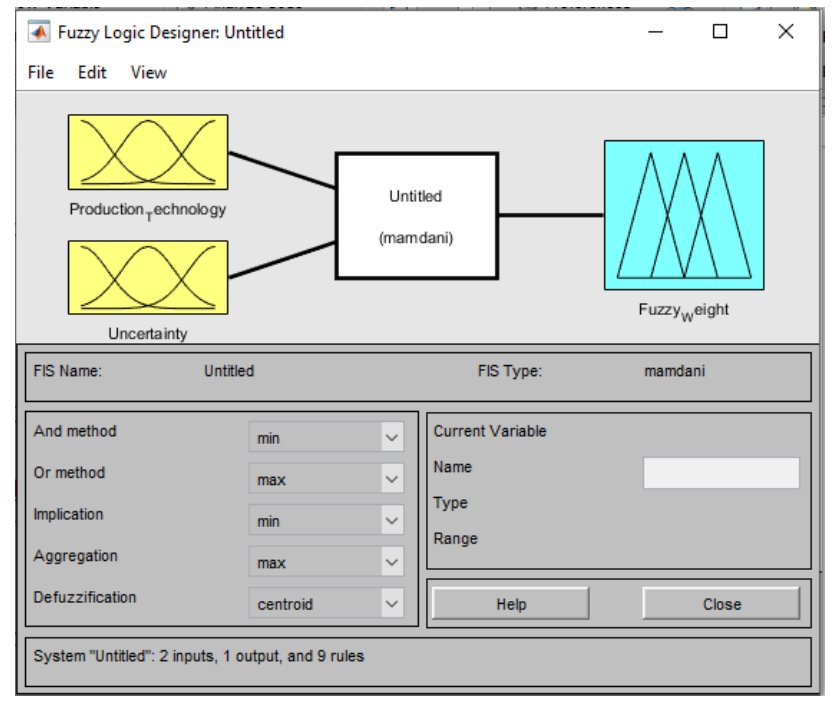
Mathematics 2022 , 10 , x FOR PEER REVIEW Figure 5. Designed fuzzy model with fuzzy membership functions. Figure 5. Designed fuzzy model with fuzzy membership functions.